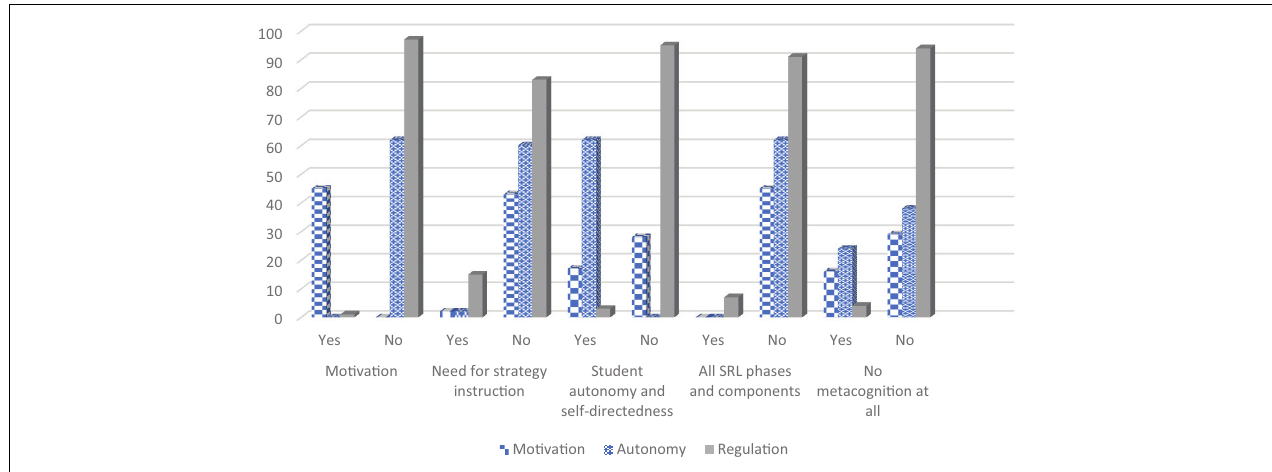
FIGURE 1 | Patterns of SRL conceptualization for the three cluster groups as a result of the two-step cluster analysis. Columns represent frequencies of codes of the 205 teachers sorted per cluster